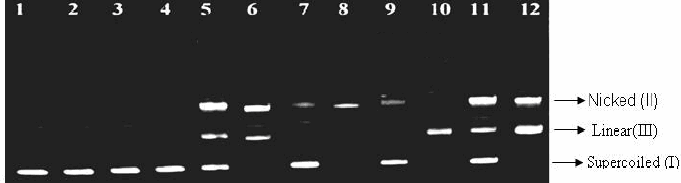
Figure 4. Agarose gel (1%) showing the results of electrophoresis of 1 μ L of (0.10 μ g/mL) pBR 322 plasmid DNA, 2 μ L of 0.1 M Tris-HCl (pH 8.0) buffer: 250 µM complex in DMF; 10 μ L of sterilized water and 2 μ L of 9.0 mM H 37 °C (120 min) Lane 1: DNA (control); Lane 2: DNA + H BMOT; Lane 4: DNA + BMOT + H